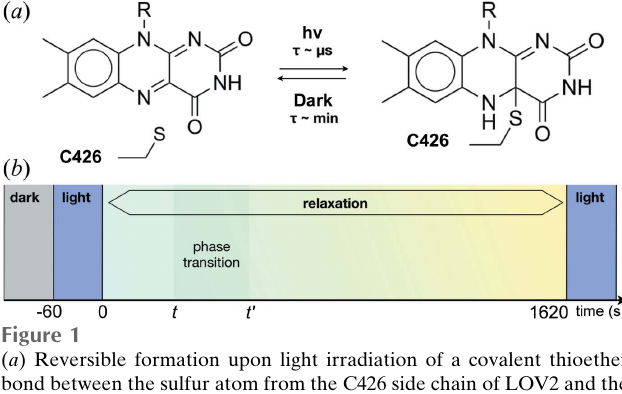
Figure 1 ( a ) Reversible formation upon light irradiation of a covalent thioether bond between the sulfur atom from the C426 side chain of LOV2 and the C4a atom of the isoalloxazine ring of the FMN. ( b ) Schematic of the time domains explored in this study. The ground state of LOV2 is probed in the dark (grey). A photostationary equilibrium between the ground state and the photoadduct is built up under steady blue-light illumination for 60 s (blue). Relaxation of the photoadduct is monitored over 1620 s (cyan to yellow gradient). The existence of a crystalline phase transition (light grey) is probed during the relaxation